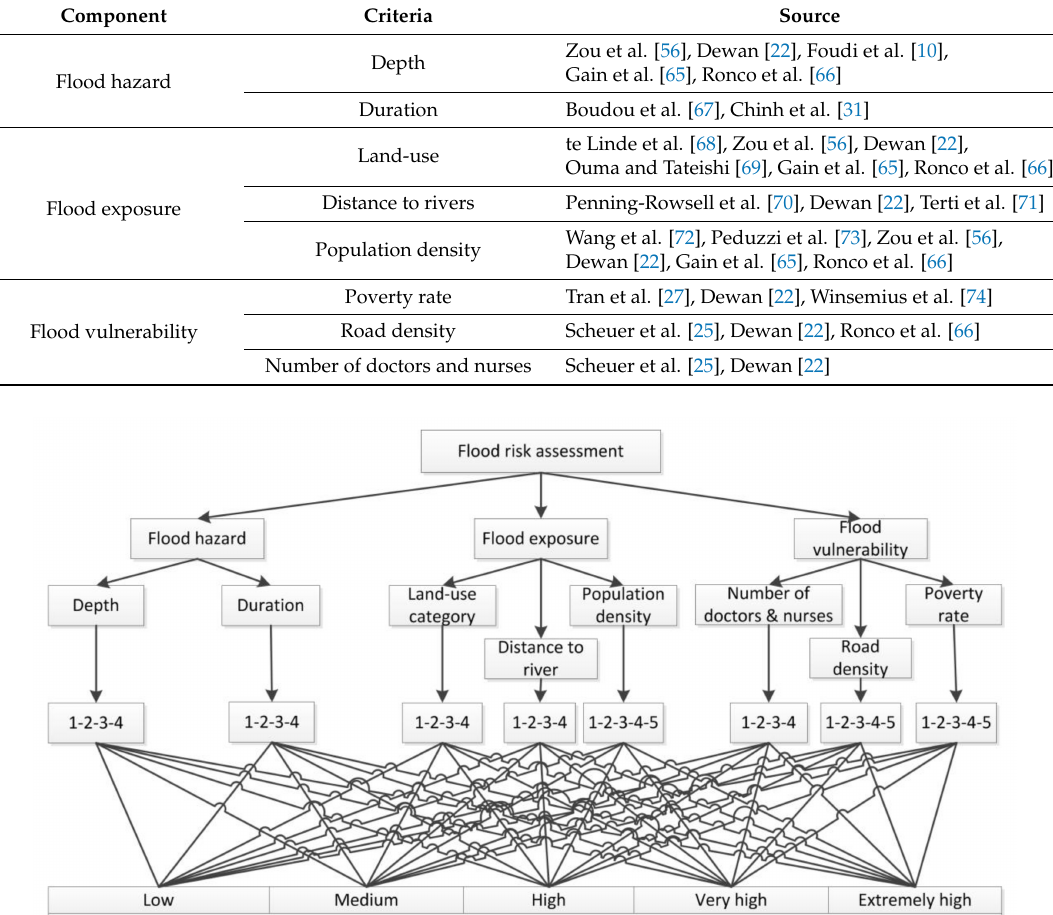
Table 1. Criteria and its sources for assessing flood hazard, vulnerability, and exposure.